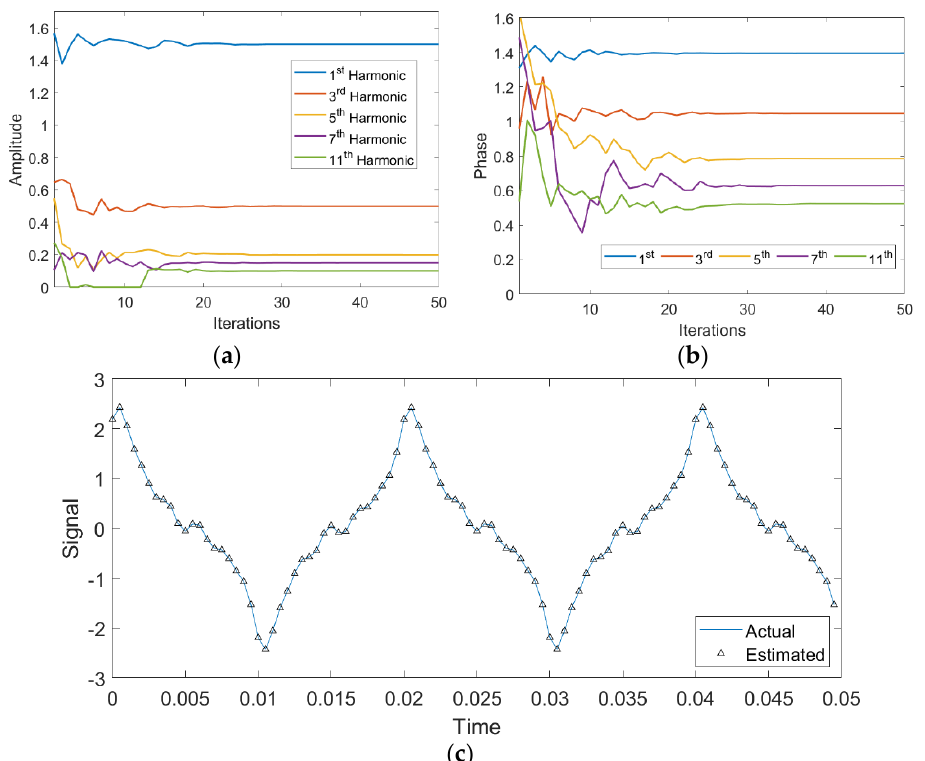
Figure 6. Plots of parameters estimates for 0.4 λ and 70 dB δ . ( a ) amplitude ( b ) phase ( c ) curve-fitting.